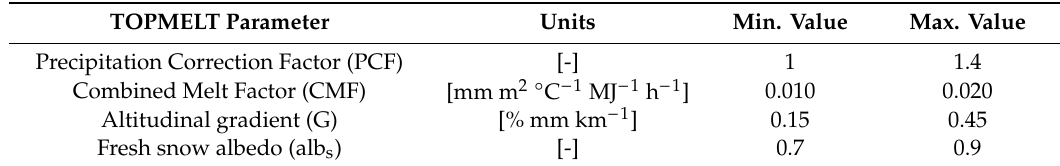
Table 2. TOPMELT parameters and their relative range of variation adopted with the GLUE procedure. TOPMELT